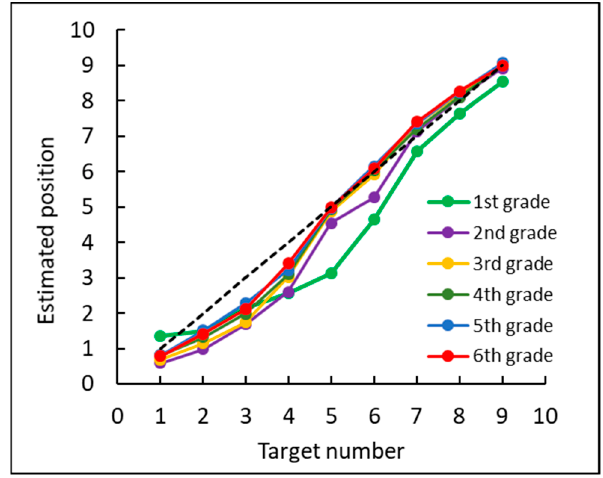
Figure 5. The mean estimated position of each target number for each grade. The dashed black line indicates the correct position of each target number ( x = y ).